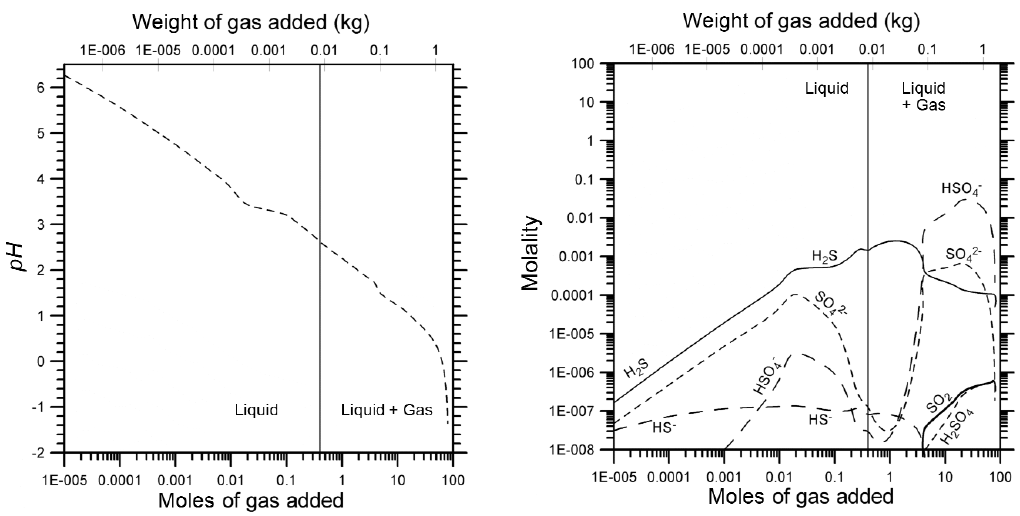
Fig. 6. Changes in the pH of the aqueous solution during the progressive addition of hot (915°C) mag- matic gas into 1000 g of pure water initially at 25°C. Pressure was kept at 0.1 MPa throughout the simula- tion.